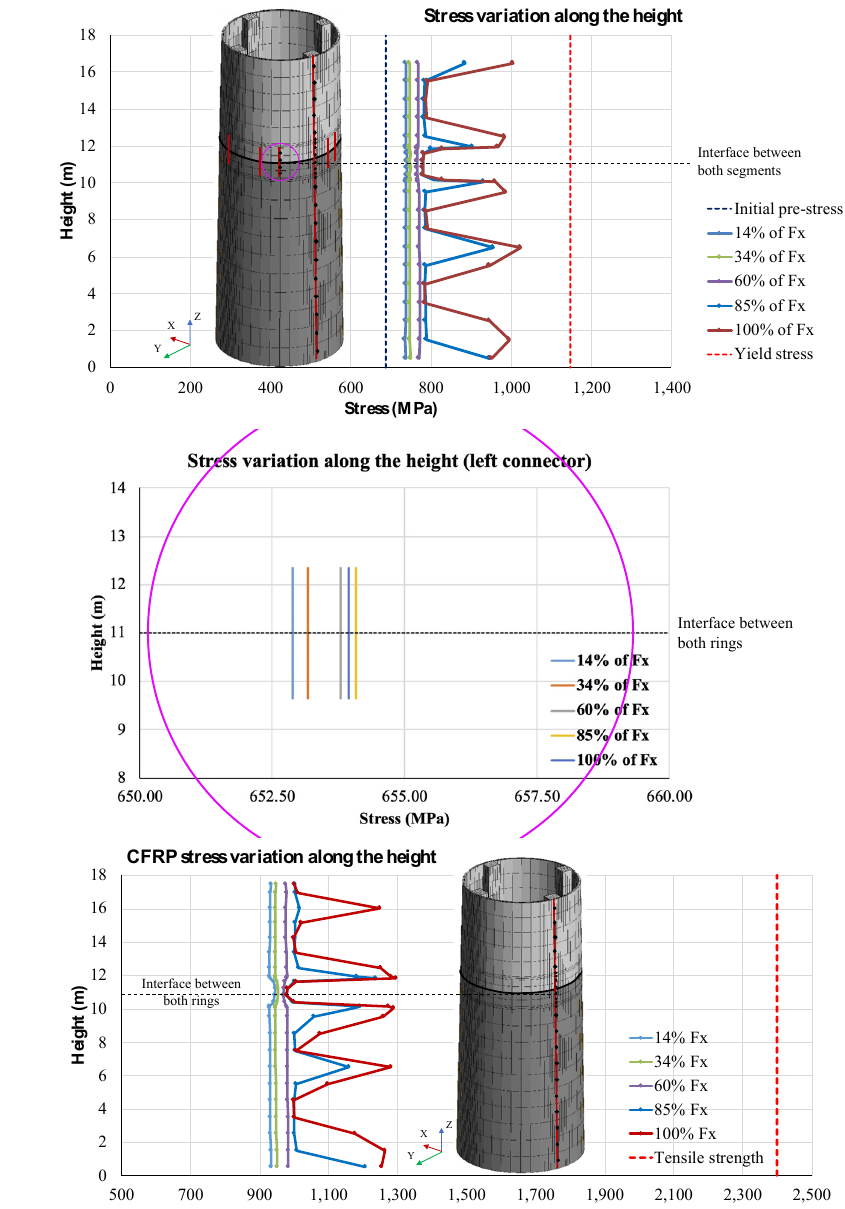
Figure 7. Evolution of the stress field in the: (a) post ‐ tensioned steel cables; (b) post ‐ tensioned steel connectors and (c) pre ‐ tensioned CFRP bars, for different load combinations, model